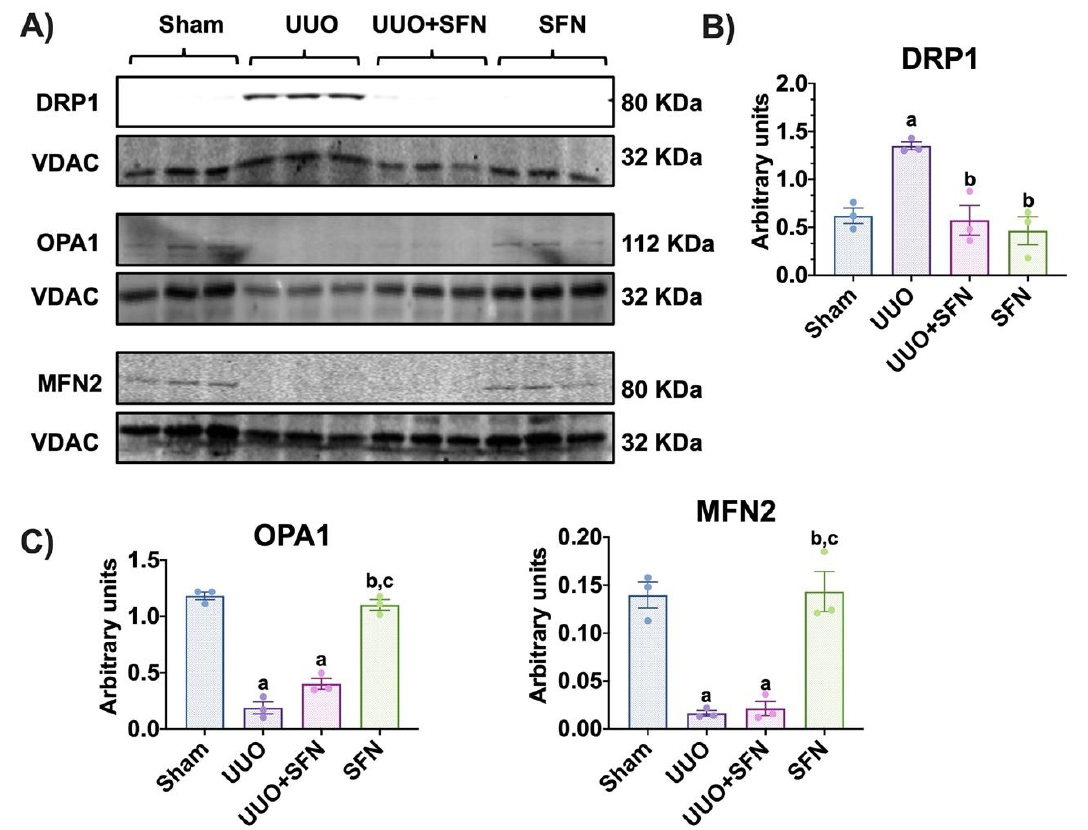
Figure 10. Sulforaphane (SFN) decreases the fission process in isolated mitochondria in the unilat- eral ureteral obstruction (UUO) model. ( A ) Representative immunoblotting and densitometric anal- ysis of protein levels of the ( B ) fission protein dynamin-related protein-1 (DRP1) and ( C ) fusion proteins optic atrophy type 1 (OPA1) and mitofusin 2 (MFN2). Data are mean ± SEM, n = 3 per group. Data were analyzed using a one-way ANOVA, and statistical differences were determined by multiple comparisons using Tukey’s test. A voltage-dependent anion channel (VDAC) was used as the loading control. a p < 0.05 vs. Sham, b p < 0.05 vs. UUO, c p < 0.05 vs. UUO + SFN. Sham: simu- lated surgery without ligation of the ureter; UUO: unilateral ureteral obstruction with double liga- tion of the left ureter for seven days; UUO + SFN: UUO treated with SFN (1 mg/kg, intraperitoneal); and SFN: administered with SFN (1 mg/kg, intraperitoneal).